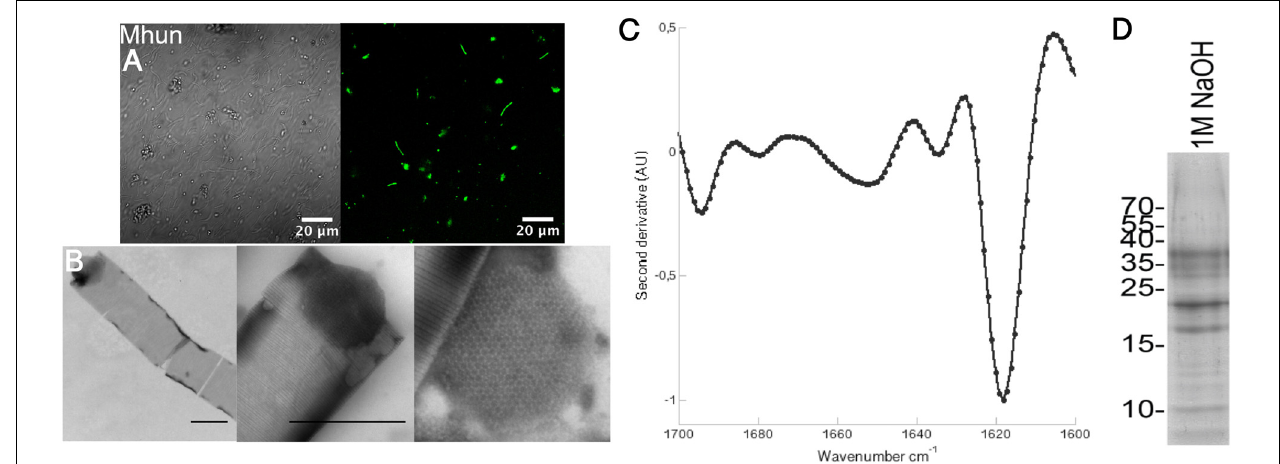
FIGURE 1 | Methanospirillum hungatei JF-1 sheaths are composed of functional amyloids that require DTT and NaOH for dissolution. (A) Binding of the amyloid-specific antibody WO1 to intact M. hungatei JF-1 (Mhun) filaments (right). The left side is a differential interference contrast image. (B) TEM images of purified sheaths from M. hungatei JF-1 at 8,000X (left) and 25,000X magnification (middle). A zoom in on a spacer plug with its hexagonal arrangement of subunits is shown on the right. Scale bars correspond to 500 nm. (C) Normalized second derivative FTIR spectra of purified sheaths. (D) Gel bands after depolymerization of purified sheaths using DTT and